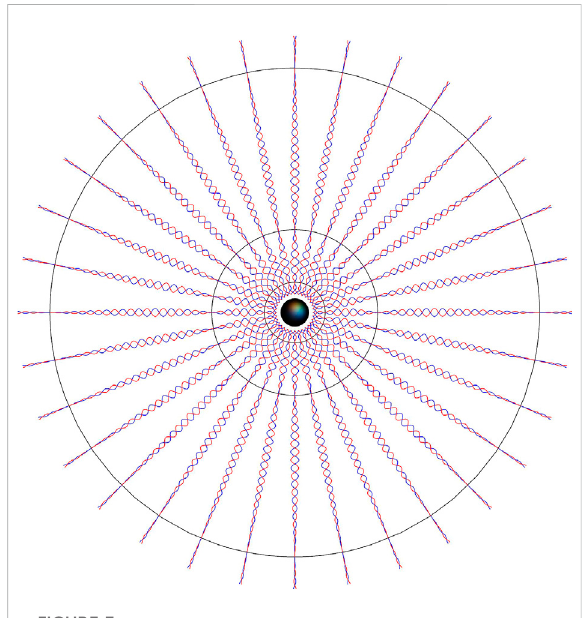
FIGURE 3 Electric potential diverges from a current-carrying wire (black, pointing straight at) as paired-photon rays (sketched as red and blue waves) whose winding matches the winding number of the charge density along the wire and decays inversely with distance, r . The magnetic fi eld lines (thin concentric circles) correspond to the lines encircling the wire at a distance where the winding is the